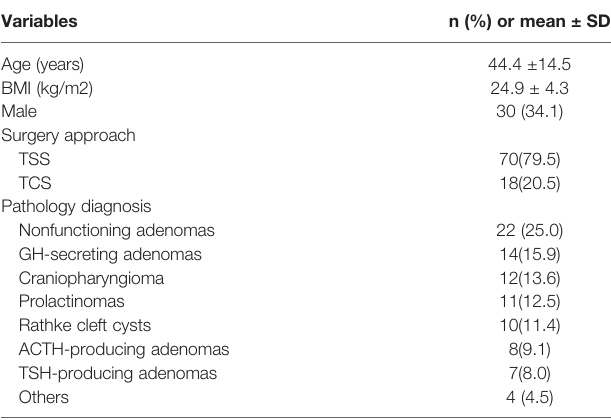
TABLE 1 | Patient characteristics and details.